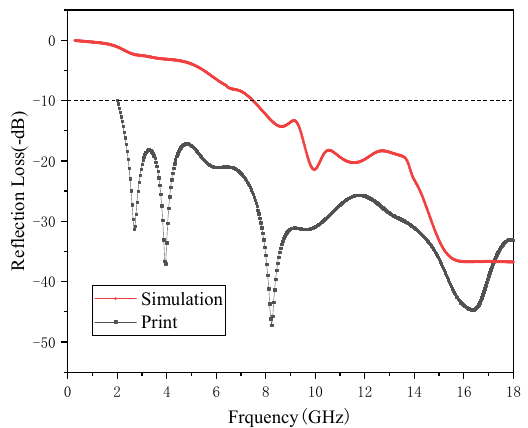
Figure 18. RL spectra of the printed pyramid absorber and simulating pyramid model.